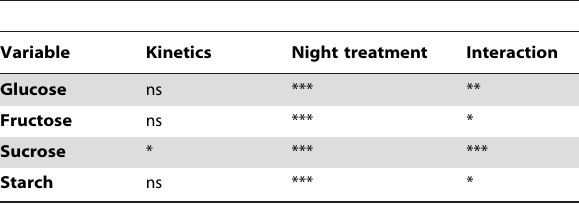
Table 4. Results of two-way ANOVA of the impact of night temperature on carbohydrate